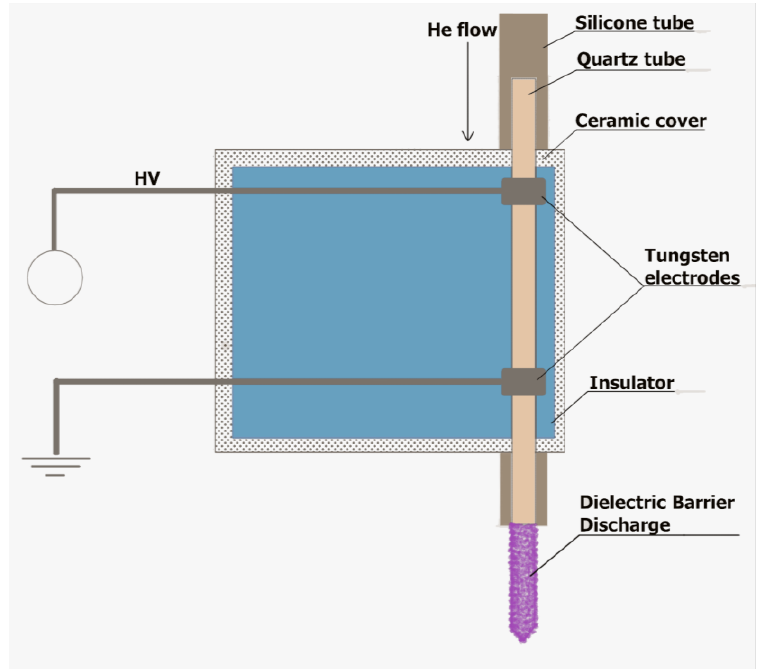
Figure 8. The scheme of the applied DBD-based portable plasma pencil.